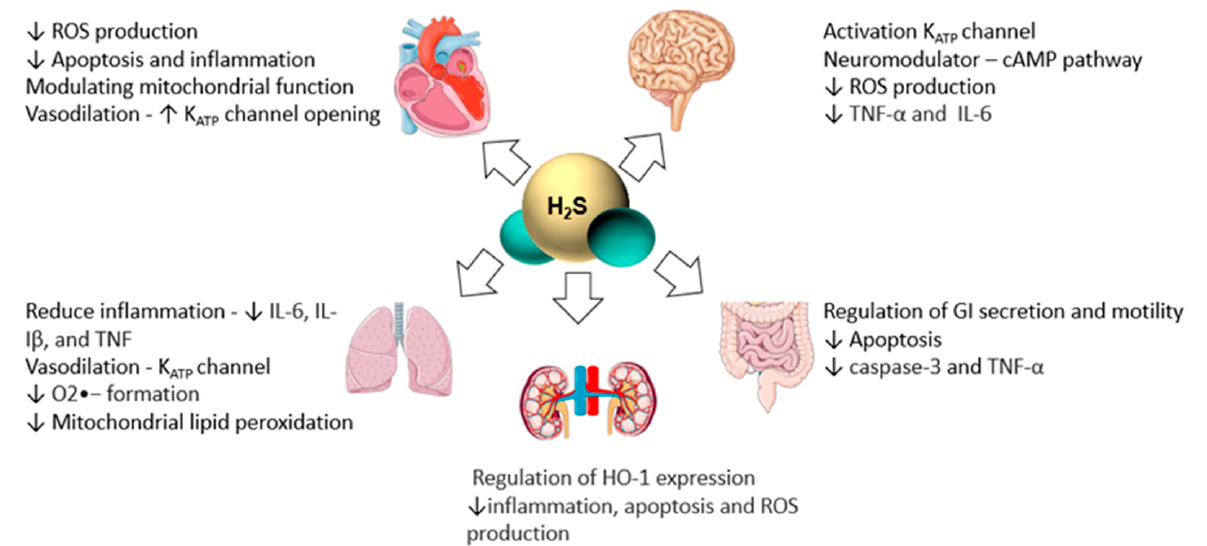
Figure 1. The physiological roles of H 2 S in mammalian systems. In cells and tissues, H 2 S is synthe- sized primarily from cysteine via cystathionine γ -lyase (CSE), cystathionine β synthetase (CBS), or 3-mercaptopyruvate sulfurtransferase (3-MST) in the transsulfuration pathway. Once produced, this gas can activate a spectrum of biochemical and physiological processes in cells to mediate effects in the brain, cardiovascular system, and other sites important for proper homeostatic function in vivo .